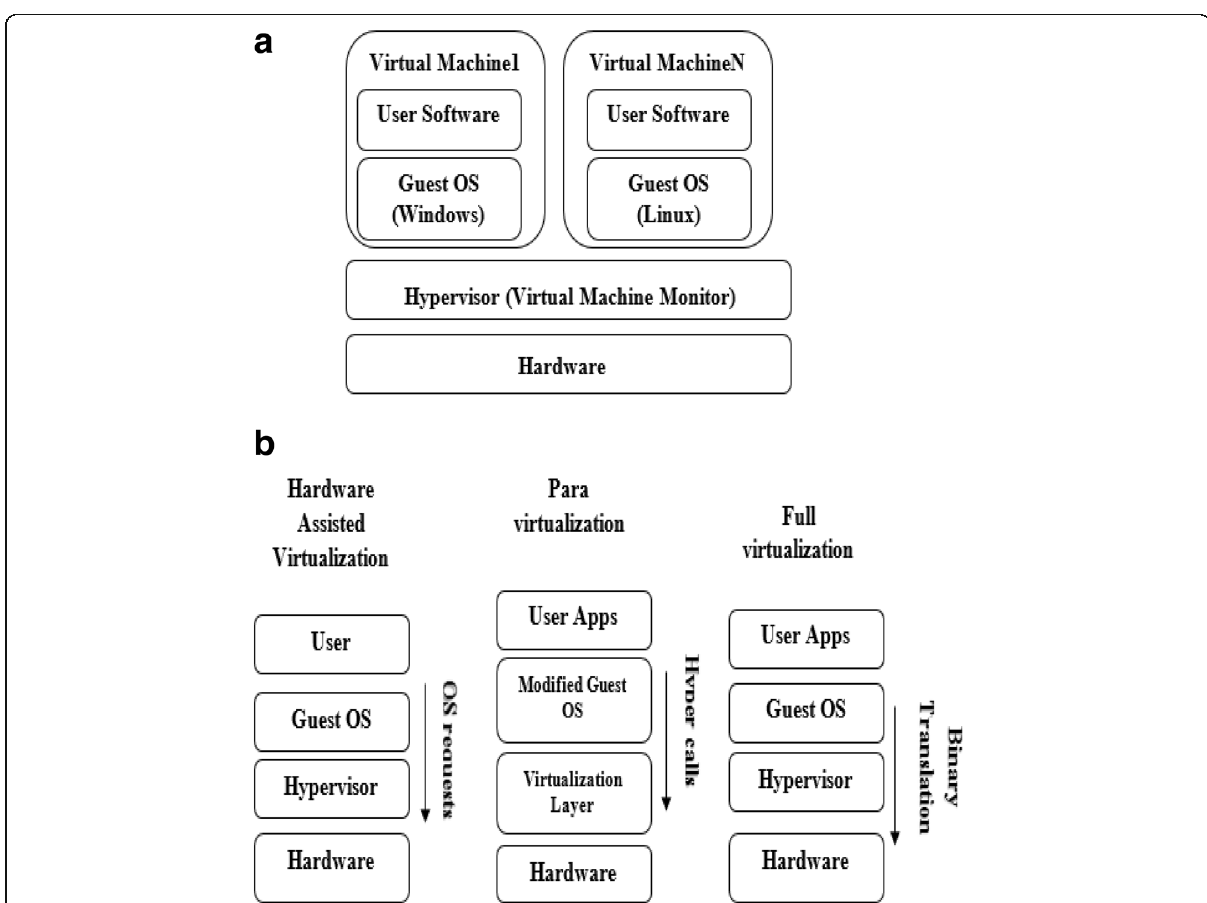
Fig. 1 a Virtual machines with different operating system hosted on hardware virtualized serve. b Types of hardware